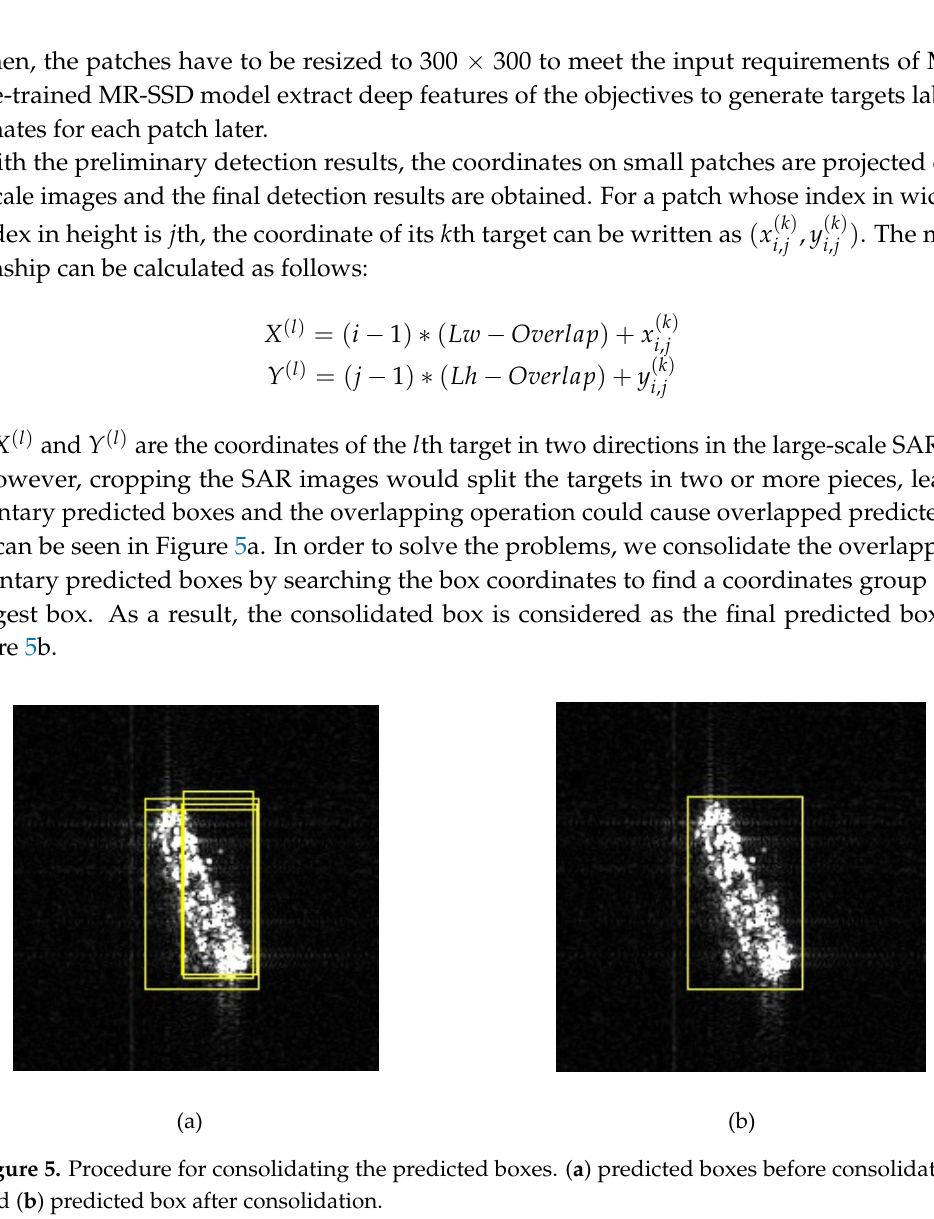
Table 1. Composition of the GF-3 SLC dataset. 348